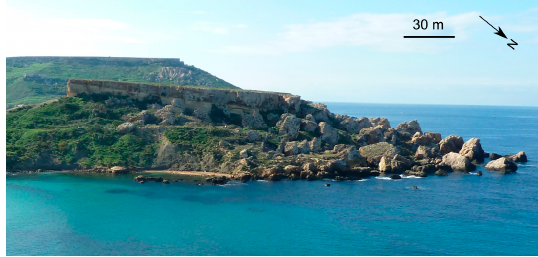
Figure 14. Il-Qarraba peninsula seen from the north.